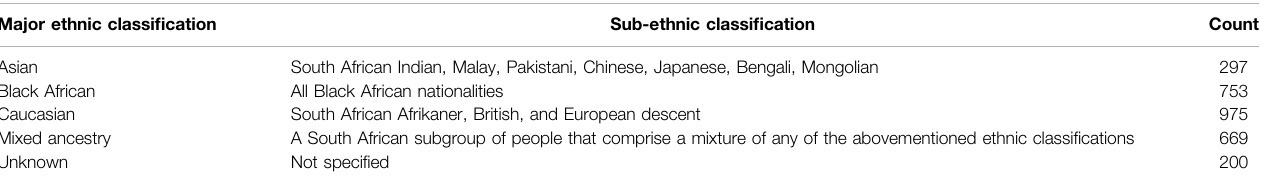
TABLE 1 | Self-identi fi ed ethnicity of consecutive BC and/or OVC patients included in the study ( n =